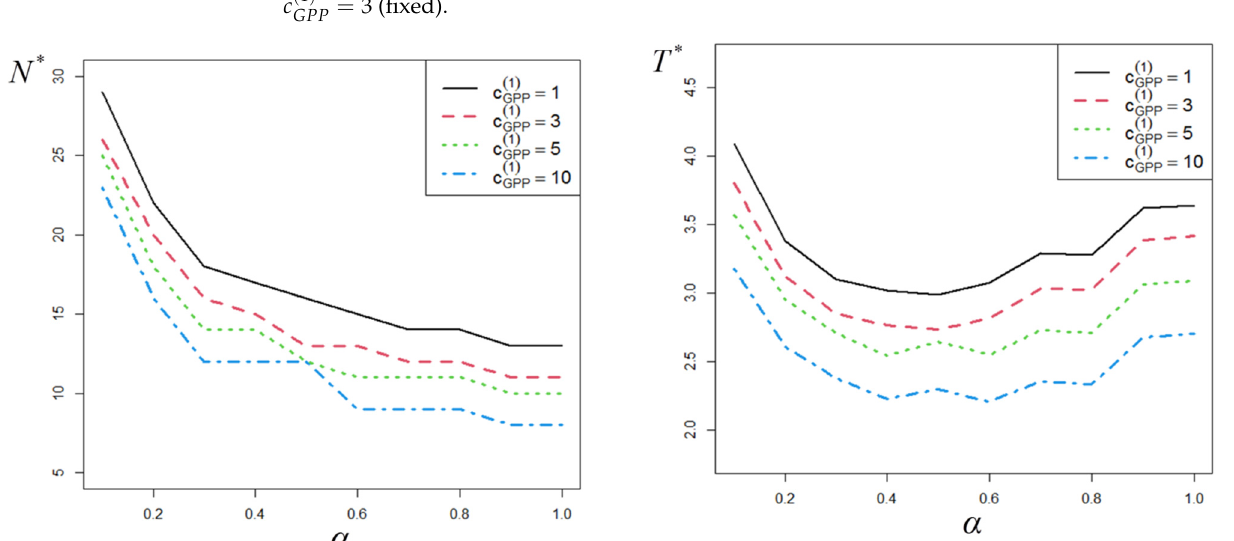
( 2 ) when β = 1, c r = 80, GPP